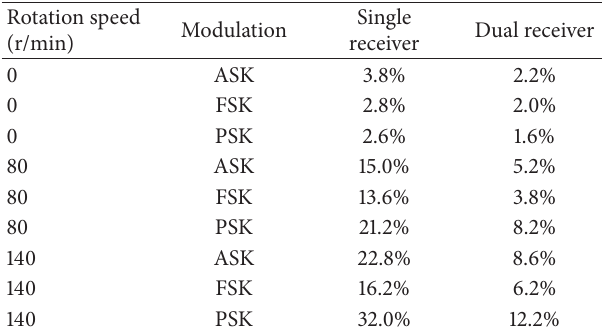
Table 4: The measured average BER for three basic modes of mod- ulation at different rotation